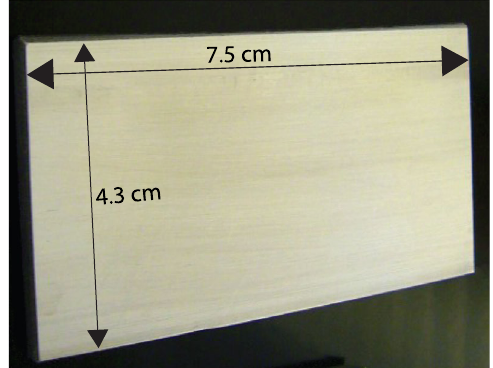
FIG. 5. In-plane diffuse scattering distributions for high energy photons. The curves are calculated from the approximate relation given in Eq. (14).